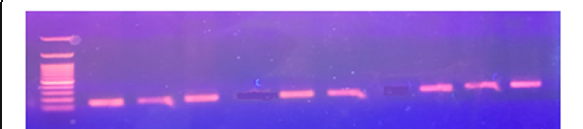
Fig. 1 Separation of DYS14 gene PCR amplification products by gel electrophoresis. Samples are shown from left to right; DNA marker, positive control by using pure semen sample, mixture of blood and semen in a ratio of 1:1, mixture of 70% blood and 30% semen, empty lane, mixture of 30% blood and 70% semen, mixture of menstrual blood with 50% semen, empty lane, mixture of menstrual blood with 30% semen, mixture of menstrual blood with 70% semen and last lane contained the mixture of all three